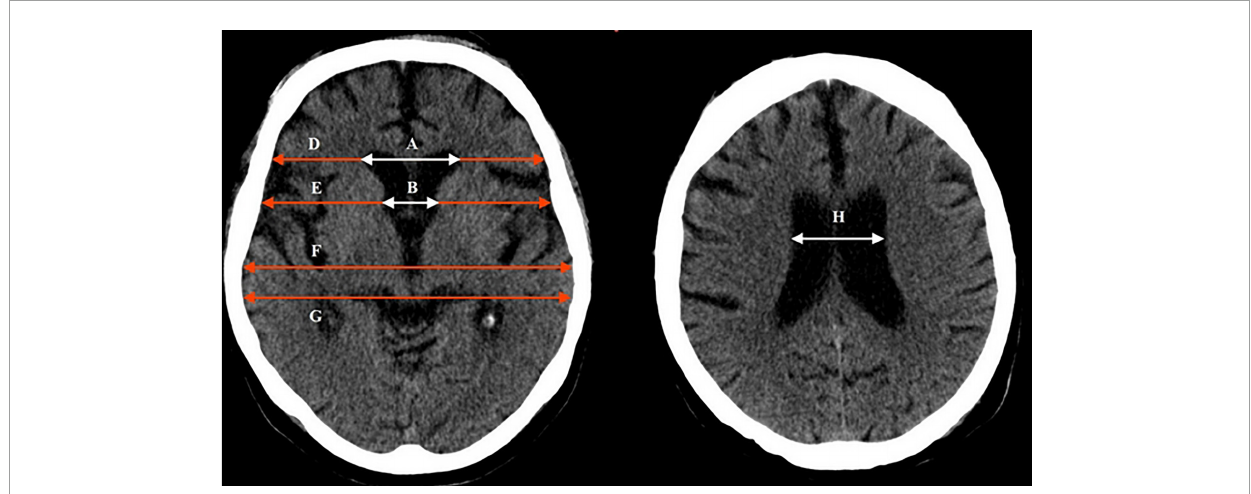
FIGURE1 Brain computed tomography, indicating the different indices used in this study and how they were calculated: Bifrontal index = maximum width of frontal horns/skull width at the same level = A/D. Evans index = maximum width of frontal horns/skull width at the level of the third ventricle = A/F. Bicaudate index = minimum width of lateral ventricles/skull width at the same level = B/E. Ventricular index = minimum width of lateral ventricles/maximum width of frontal horns = B/A. Cella media index = maximum width of the skull/width of lateral ventricles =